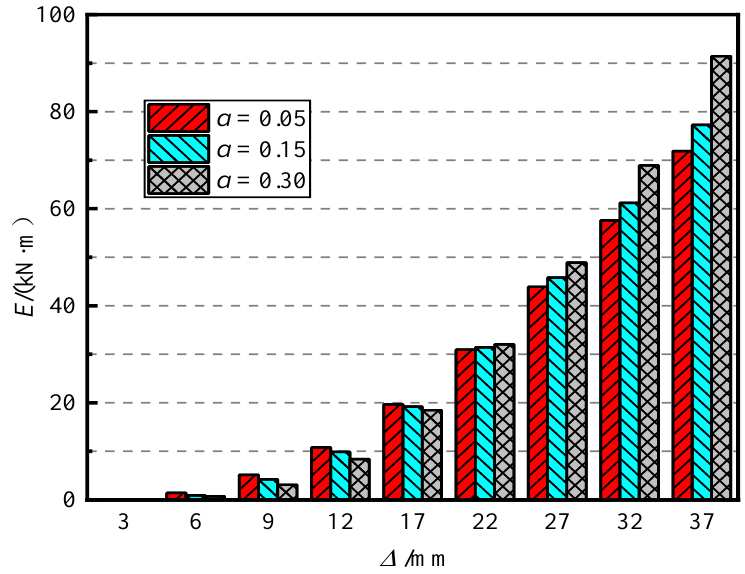
Figure 14. Cumulative energy consumption.